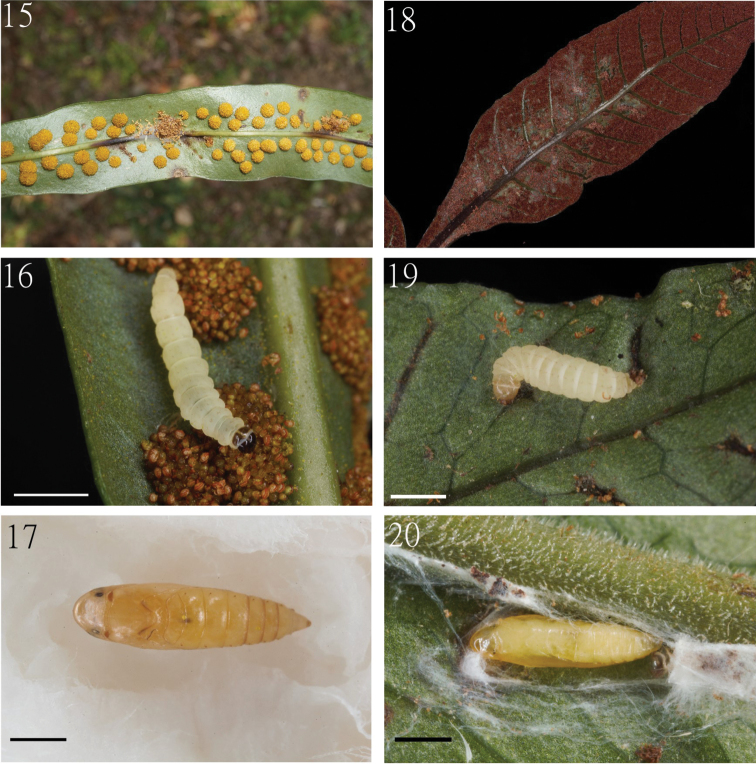
Immatures of Cuprina species 15 larval damage by C.
atayalica sp. nov. on Microsorum
brachylepis16 larva of C.
atayalica sp. nov. 17 the pupa of C.
atayalica sp. nov. 18 larval damage by C.
insolita sp. nov. on Tectaria
harlandii19 larva of C.
insolita sp. nov. 20 pupa and cocoon of C.
insolita sp. nov. Scale bars: 1 mm.